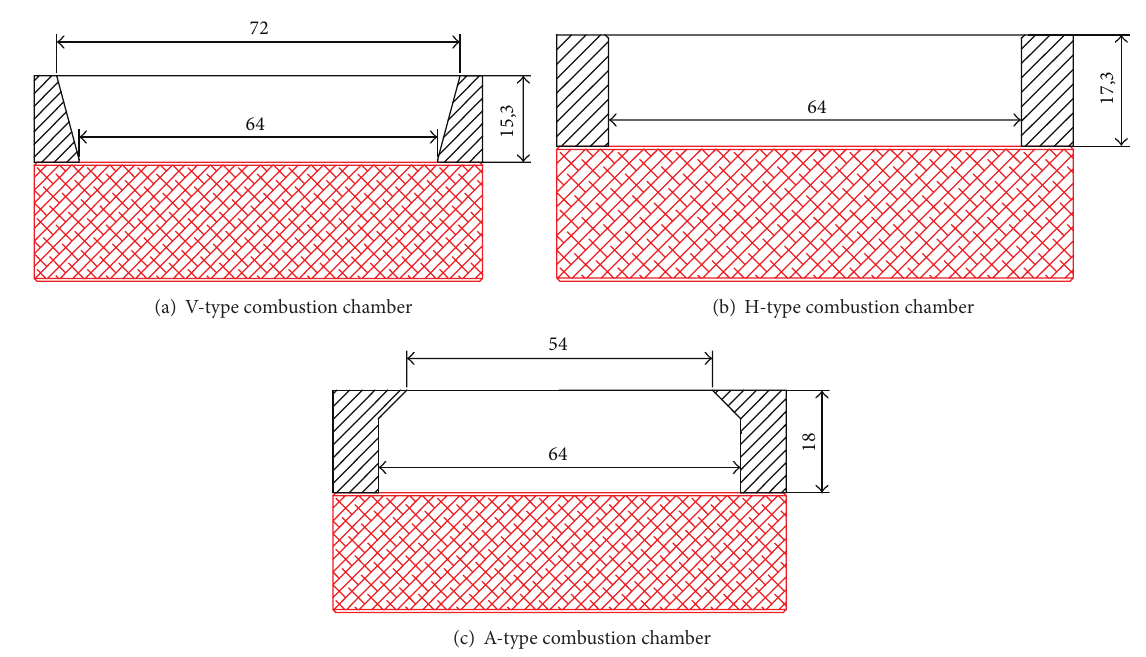
Figure 9: Various piston bowl geometries with the same compression ratio, squish distance, and visible area